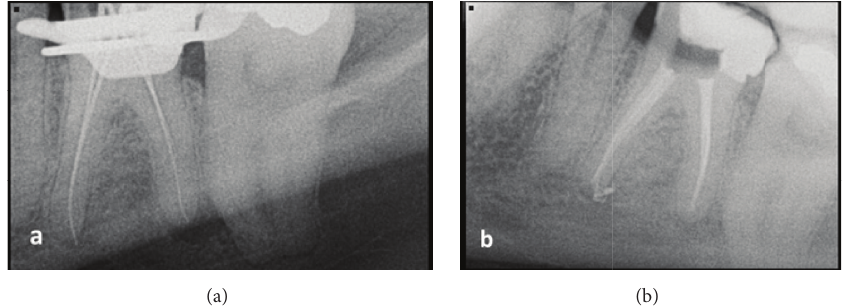
Figure 6: (a) Radiograph for working length confirmation: case report number 2. (b) Final radiograph: case report number